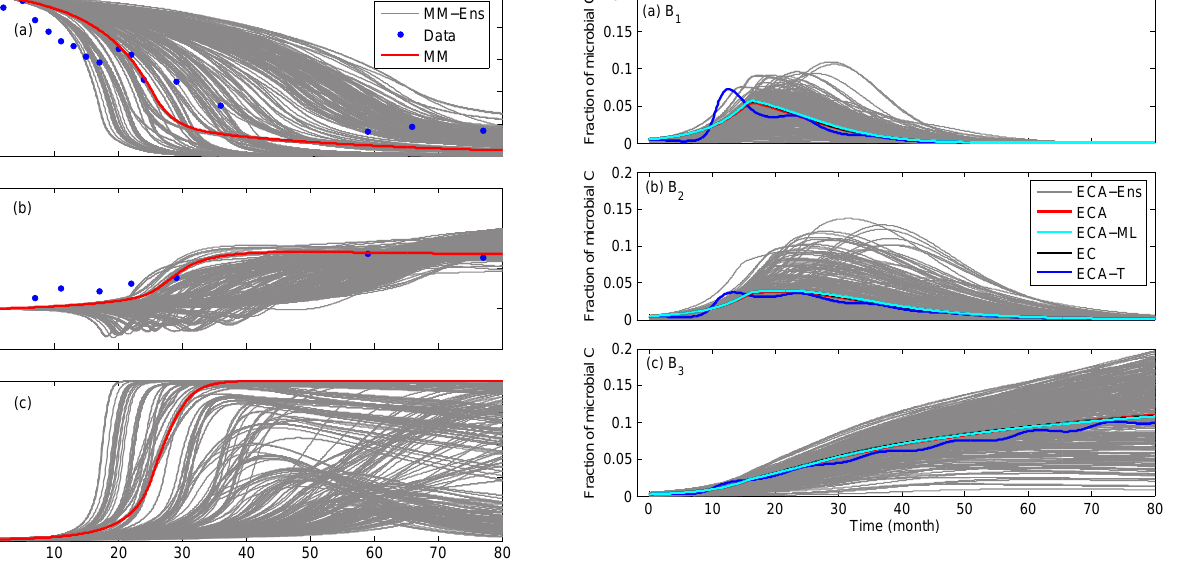
Fig. 13. Simulated time series of microbial abundances from using the best-fit parameters (calibrated with S3B3-ECA) in Table 5. The four models ECA, ECA-ML, EC, and ECA-T used the same kinetic parameters. The ECA-Ens simulations correspond to the ensemble simulations in Fig.